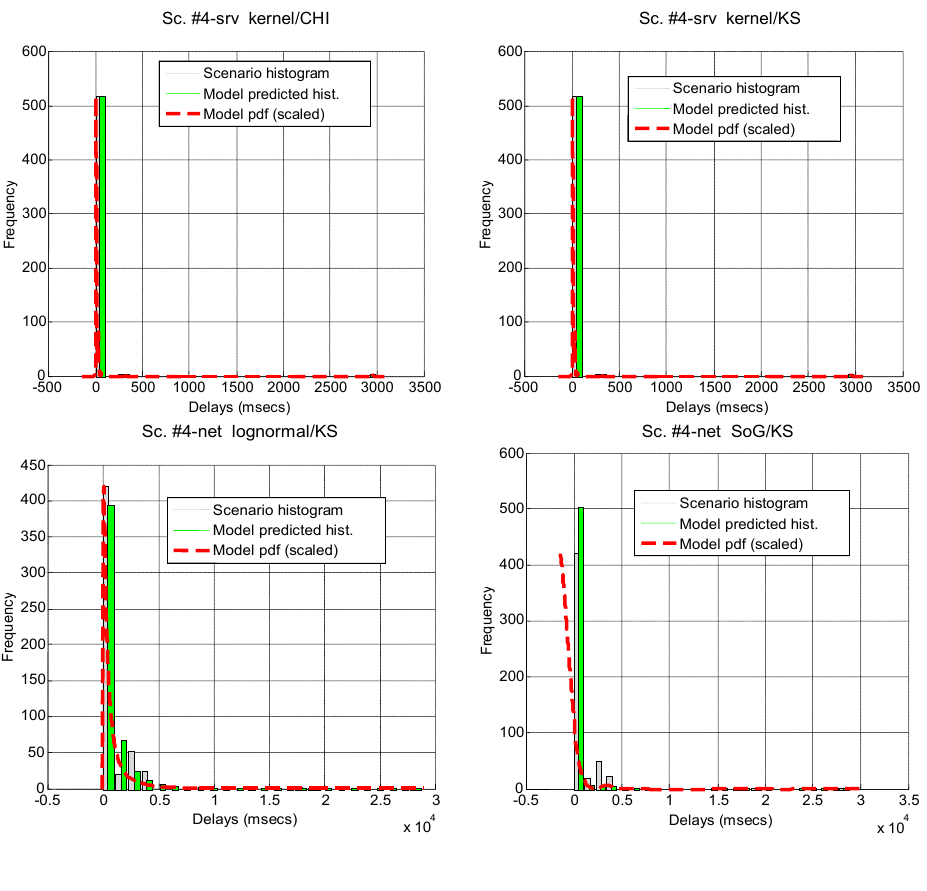
Scenario histogram Model predicted